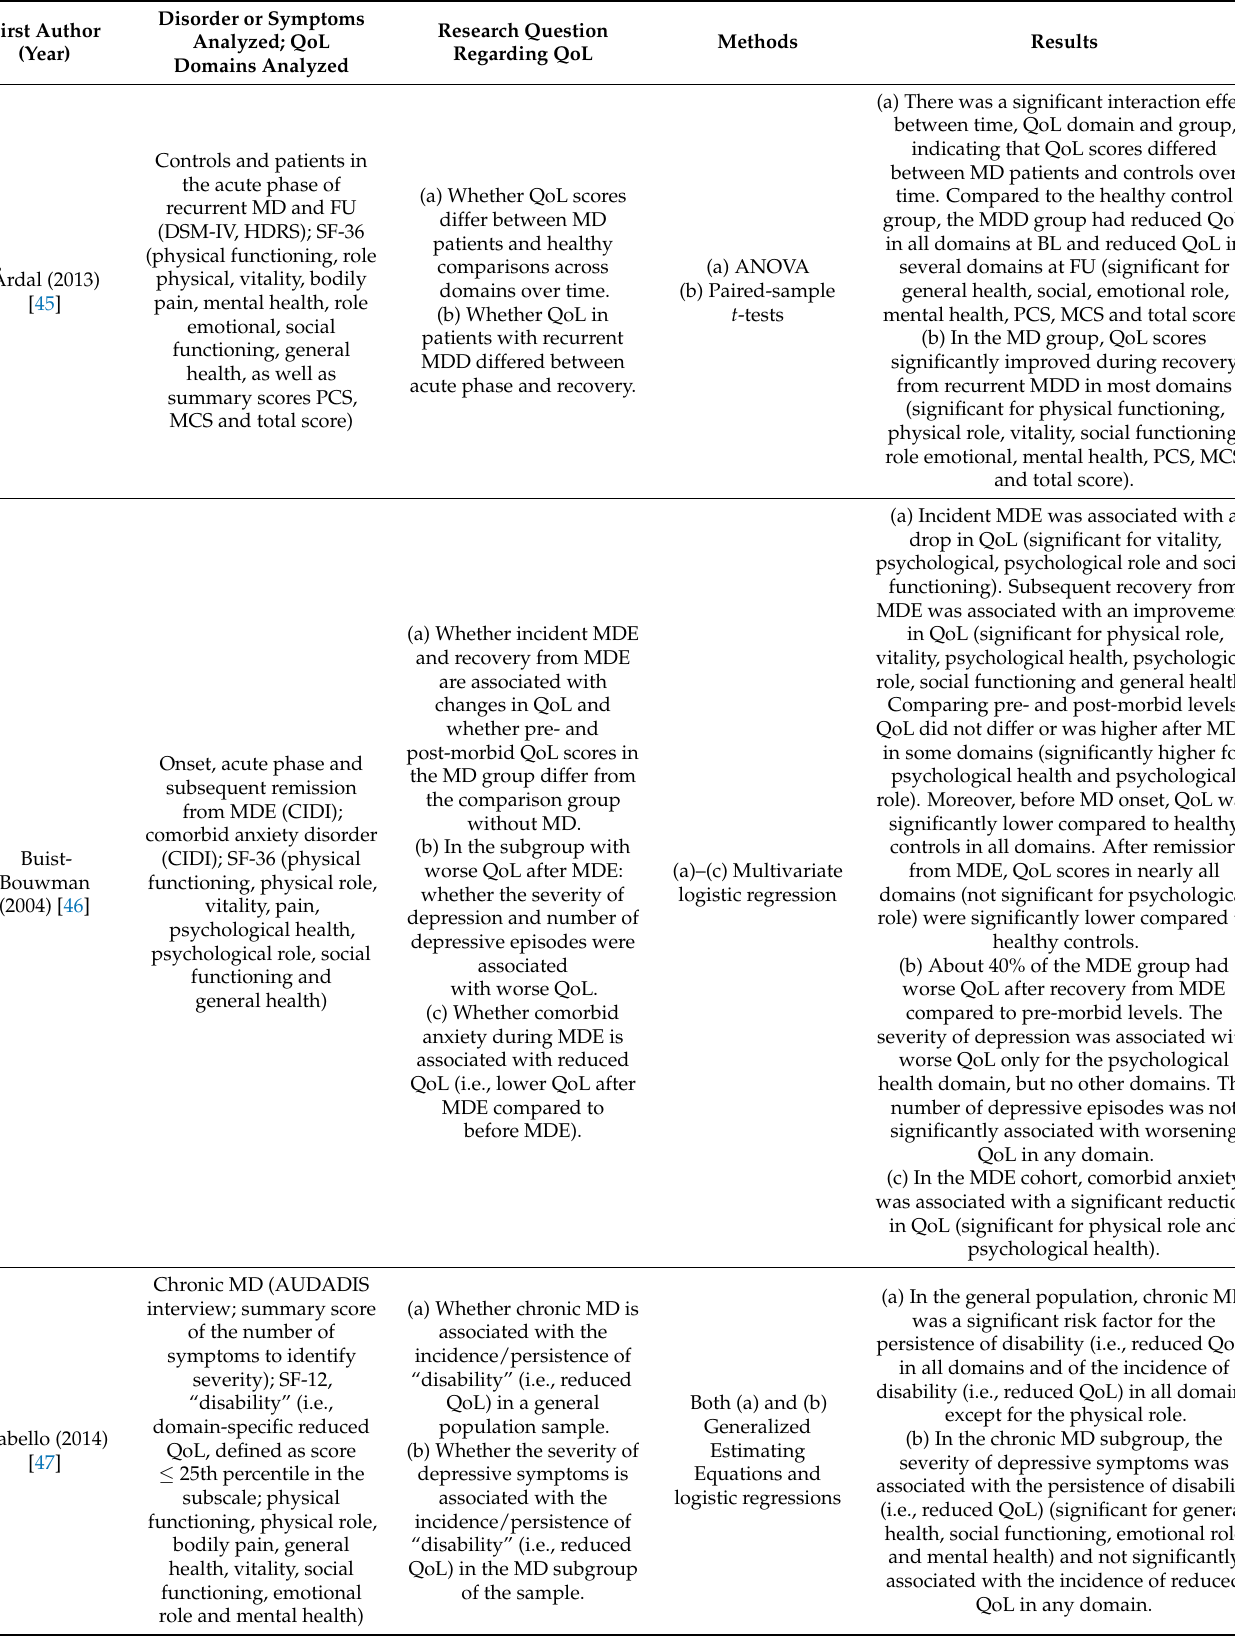
Table 2. Studies on depression/anxiety as independent variables and QoL